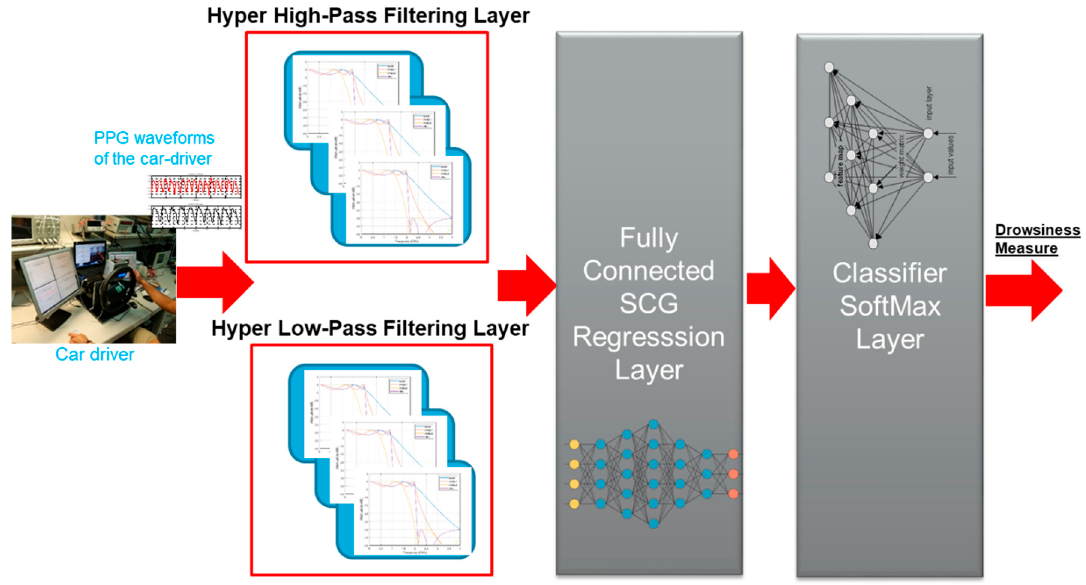
Figure 6. The proposed PPG drowsiness monitoring pipeline based on the use of Hyper-filtering layers and SCG (Scaled Conjugate Gradient) regression network.